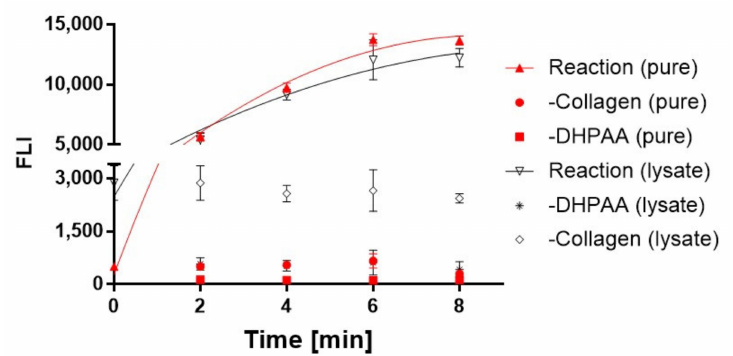
Figure 3. Reaction kinetics. Time-dependent evaluation of the collagen degradation by ColG. Aliquots from the reaction were analyzed based on the aforementioned assay at the designated time points. Concentration of the purified enzyme was set to 1 µ g/ µ L, and collagen concentration was 80 µ g/mL in both the purified and lysate-based